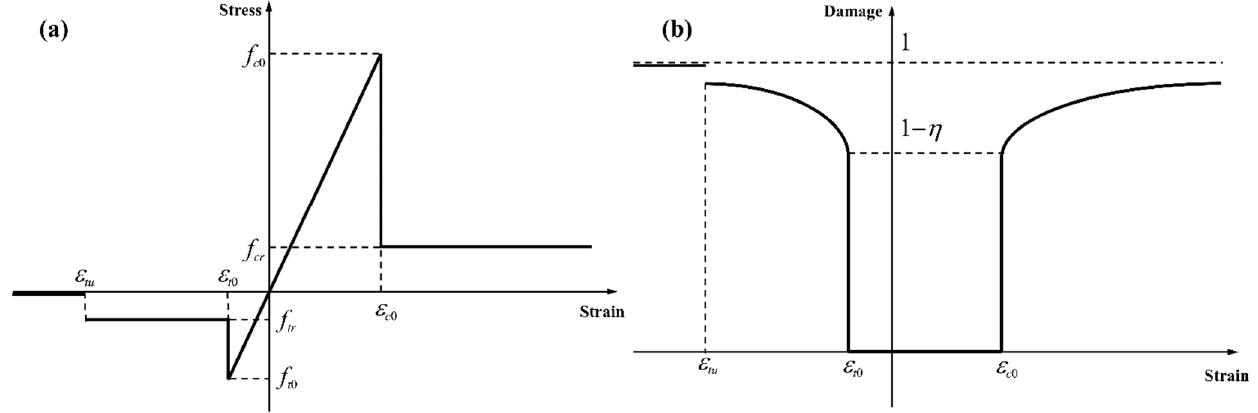
Figure 10. Mechanical response of rock under electric pulse: ( a ) Stress–strain and ( b ) damage–strain relationships in the elasto-brittle damage model of rock materials.